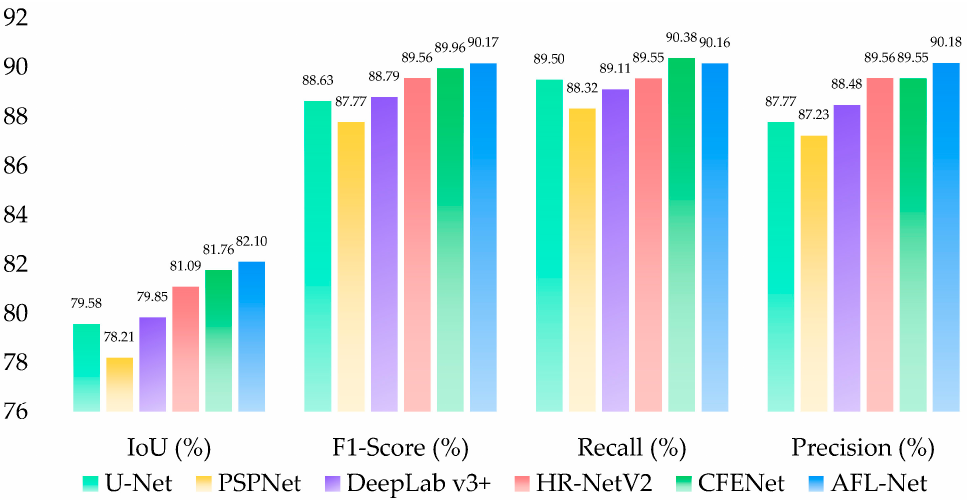
Figure 6. Comparative results from the selected models on the Inria dataset.